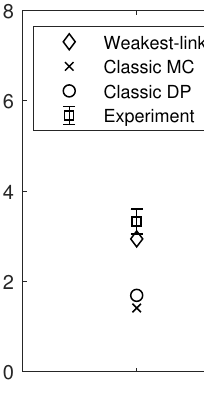
Figure 15. Two major principle stress components in the brazilian test. Each point represents the two major principle stress components at a specific load level. Points in dark grey depict the stress state at a load force of 1690N, which is the fracture force according to the classic Drucker-Prager criterion. Light grey represents the load level for the experimental fracture